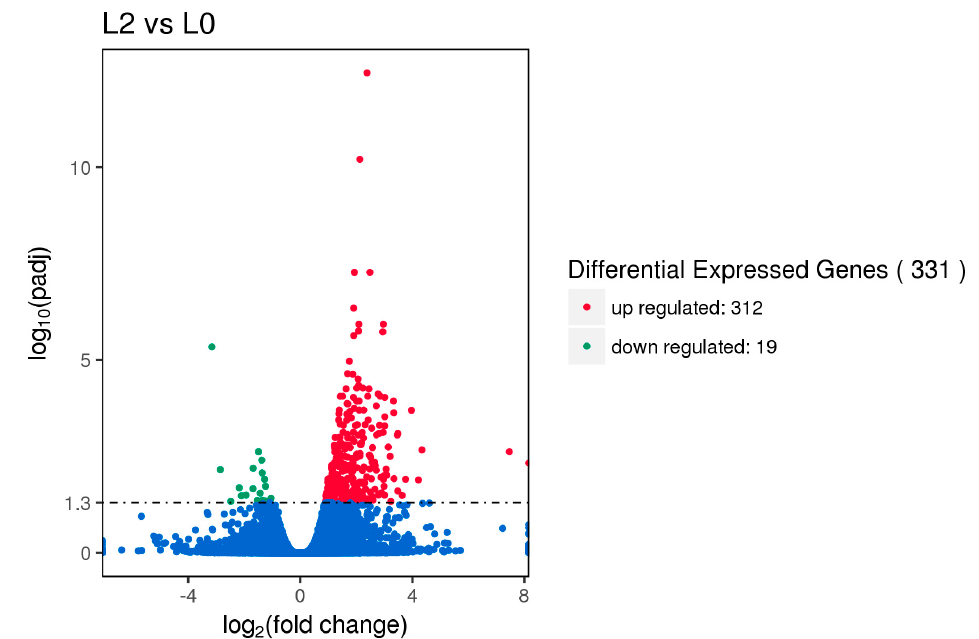
Figure 3. Volcano plot of differentially expressed genes in the ovary. DEGs were filtered using Padj < 0.05 as a threshold. Red spots represent up-regulated genes, and green spots indicate down-regulated genes. Blue spots represent genes that did not show obvious changes between the HEP and LEP samples.